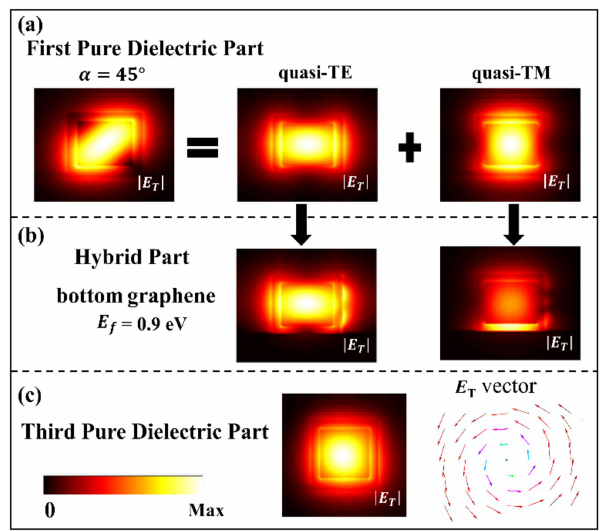
Figure 2. ( a ) Transverse component of the electric field ( | E T | ) of a linearly polarized light with α = 45 ◦